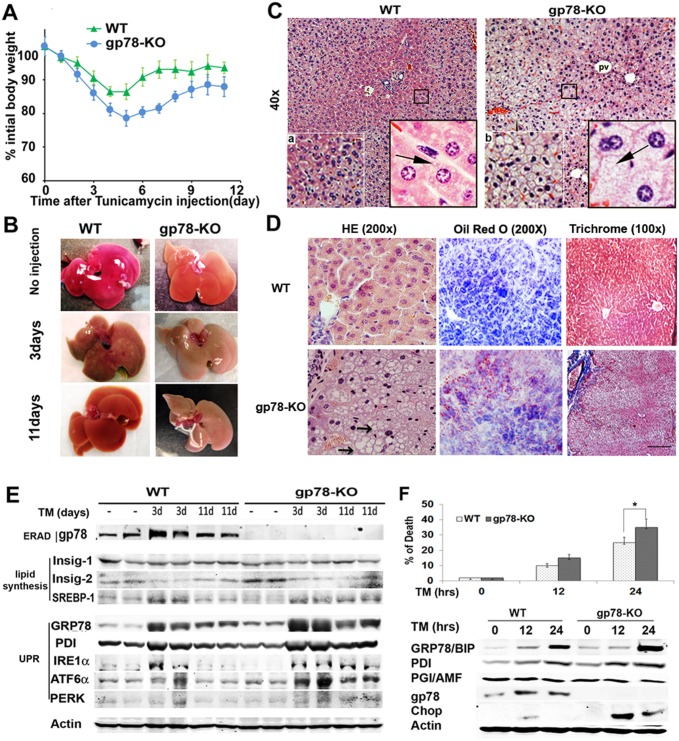
Gp78-KO mice with acute ER stress progresses to severe fatty liver through UPR-driving SREBP-1 activation.(A) 1mg/kg body weight of tunicamycin (TM) was intraperitoneally injected to 6 months-old gp78-KO mice. Body weight is represented after normalization to the starting weight as the meant ± SE (n = 3 per group). (B) Radish livers are brown colored after TM injection. Liver of gp78-KO at 11 days was not recovered. (C) Acute ER stress potentiates entire fatty liver of gp78-KO. H&E stain at 3 days after TM injection. Ballooned cells (b) are typically bigger size than WT hepatocytes (a). Cytoplasmic lipid droplets (arrow) (40x). (D) Prolonged fatty liver and fibrosis in gp78-KO. H&E, oil red and Trichrome stains at 11 days after TM injection. White ballooned cells (arrows) were maintained on H&E (200x). Frozen tissues were stained with oil-red O. Irregular fibrosis was extended from connective tissue of portal vein surrounding accumulated lipid droplets (white spots) at pinkish gp78-KO liver (100x). (E) Persistent SREBP-1 activation along with UPR up regulation is responsible for fatty liver of gp78-KO. TM-injected mice were scarified respectively (n = 3). Liver extracts at indicated days were subjected to immunoblots. GRP78, Glucose-Regulated Protein; PDI, Protein Disulfide Isomerase, SERBP; Sterol Regulatory Element Binding Transcription Factor; Insig, Insulin Induced Gene. (F) Chop-mediated apoptosis. Cell survival was analyzed with viable counting in gp78-KO mouse embryonic fibroblast (MEF) cells treated with TM (1μg/ml) as indicated times (top). Induction of UPR was analyzed in immunoblots and gp78 expression was visualized after its immunoprecipitation (bottom). Chop; ER stress-mediated apoptosis marker.